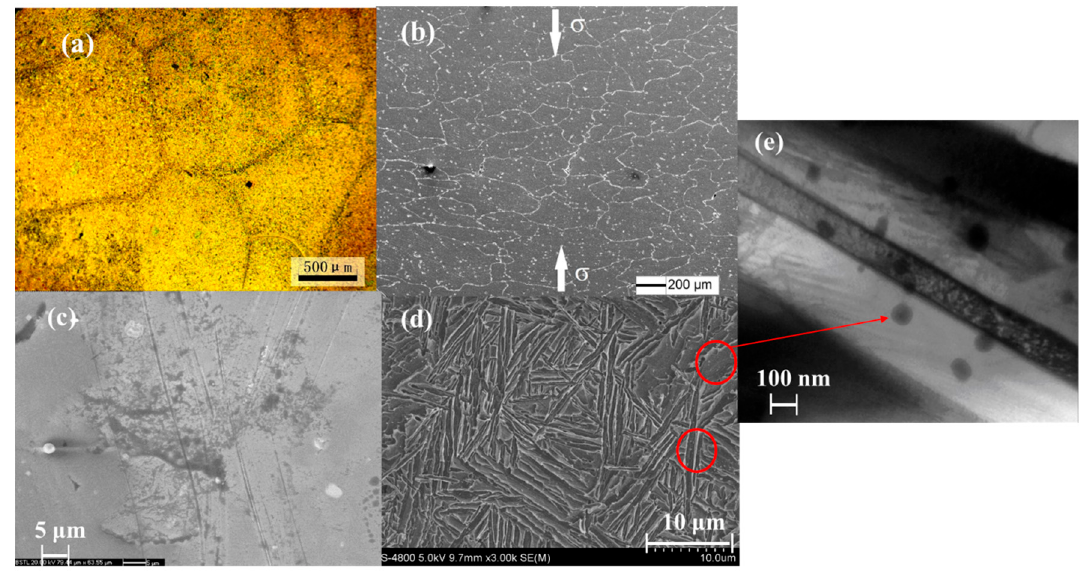
Figure 7. Effects of plastic deformation on microstructure, ( a ) undeformed grains; ( b ) 20% deformed grains; ( c ) multiple slip bands inside the grains; ( d ) microstructure of Ti-16Al-27Nb-0.6Er alloy and; ( e ) (AlTiNb) 2 Er 3 precipitates.